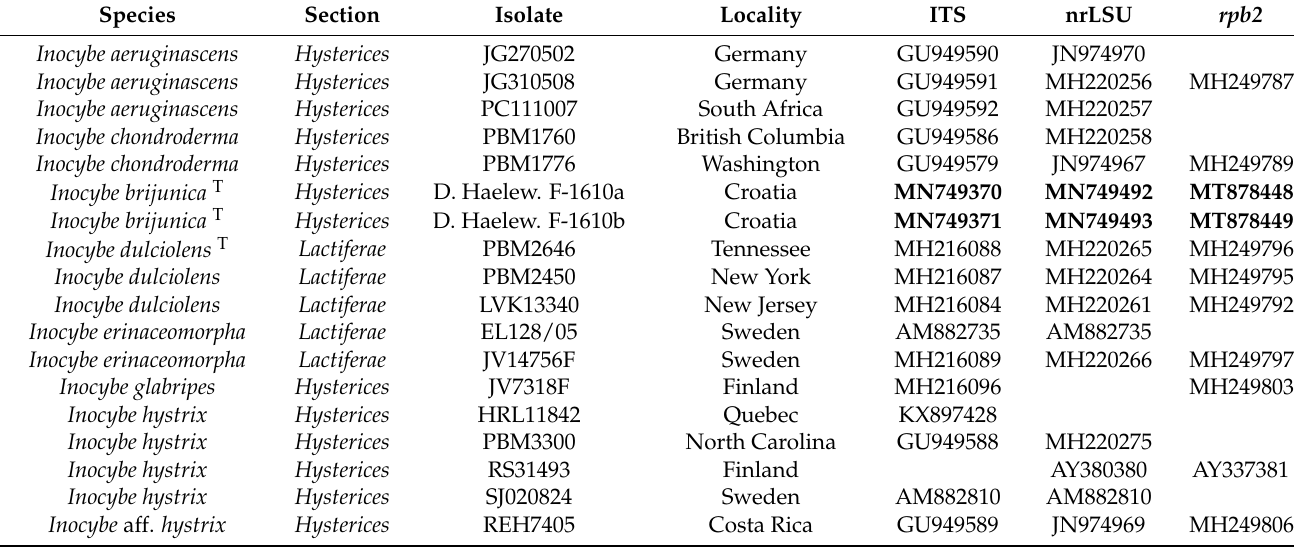
Table 1. Overview of Inocybe isolates used in phylogenetic analyses. Newly generated sequences are in boldface. T stands for type